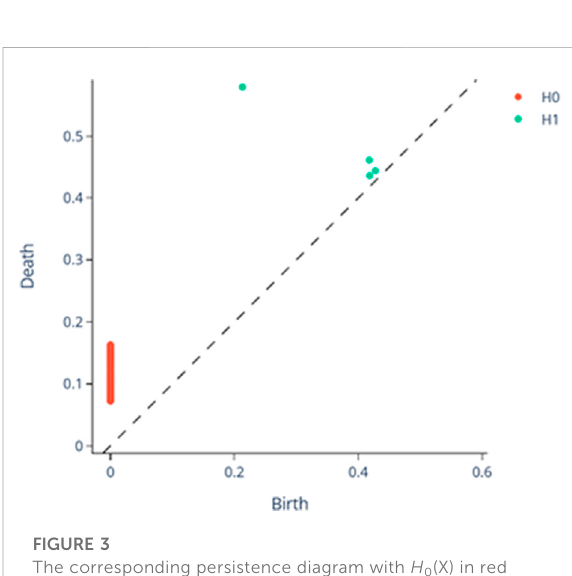
FIGURE 3 The corresponding persistence diagram with H 0 (X) in red and H 1 (X) in green, representing the persistence of connected components and holes over the ε -scale of fi